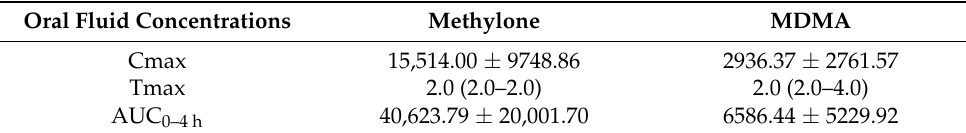
Table 2. Concentrations of methylone ( n = 8) and MDMA ( n = 6) in oral fluid.